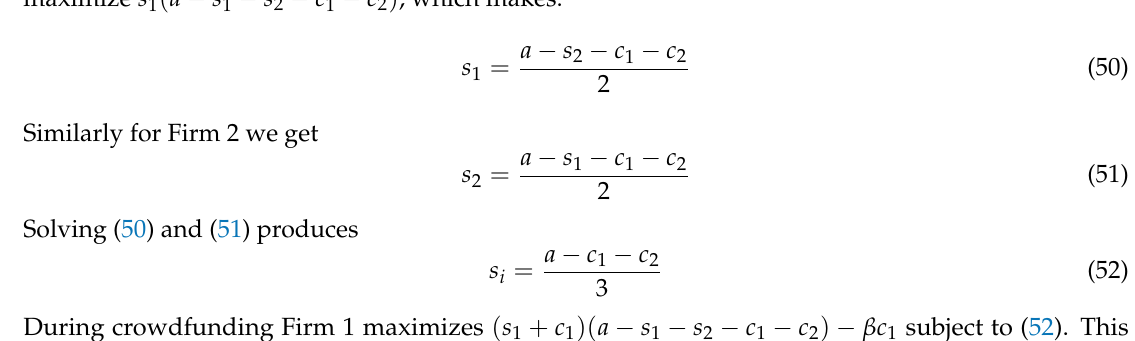
− 9 β > C ≥ a − 9 β ; ( c ) Matrix of 5 4